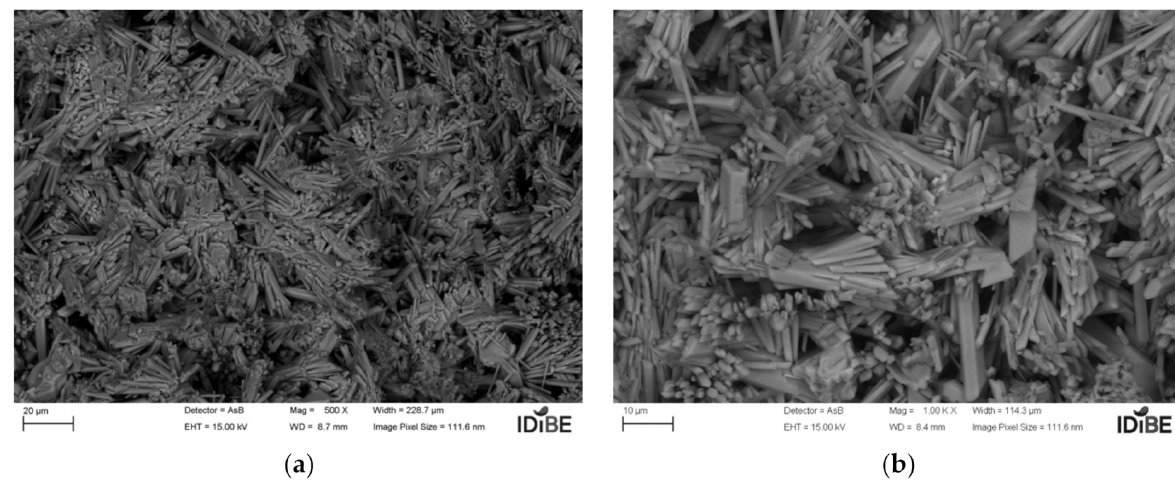
Figure 16. Micrograph of the 0.06% citric acid compound (lot I2): ( a ) 20 µ m; ( b ) 10 µ m (source: the author).